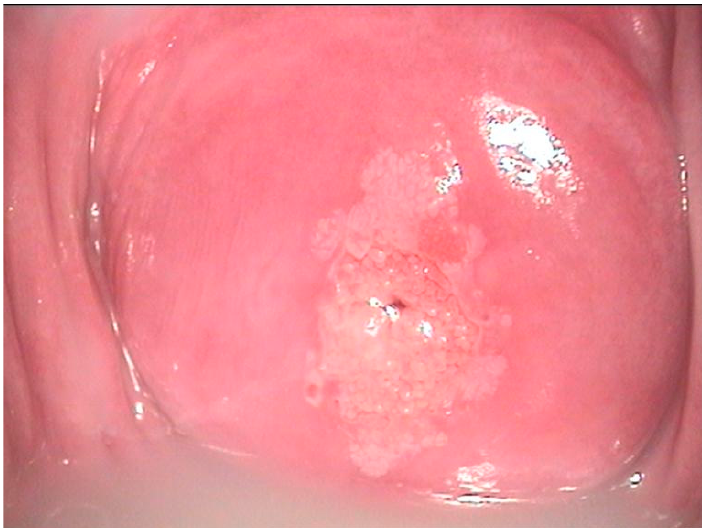
Figure 2. Colposcopic mage of a low-grade LSIL PAP smear. At the border of the ectopic epithelium, both anterior and posterior fine acetowhite epithelium with fine mosaic is noticed. At 7 o’clock, a colleret gland is present.